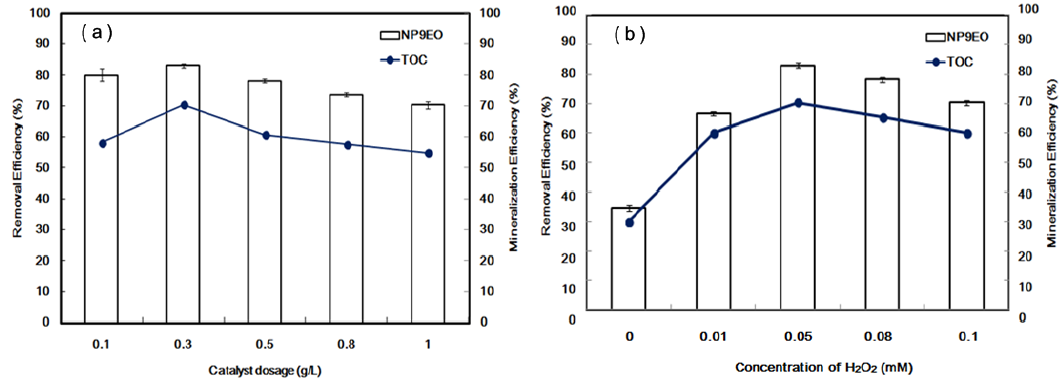
Figure 5. Schematic representation of the custom-made photoreactor.